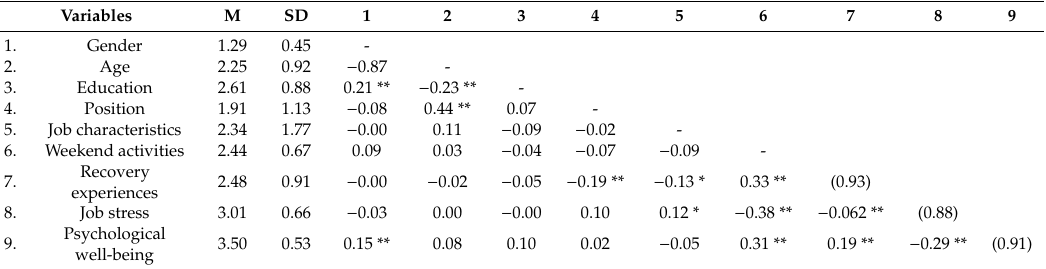
Table 1. Means, standard deviations, correlations, and reliabilities.